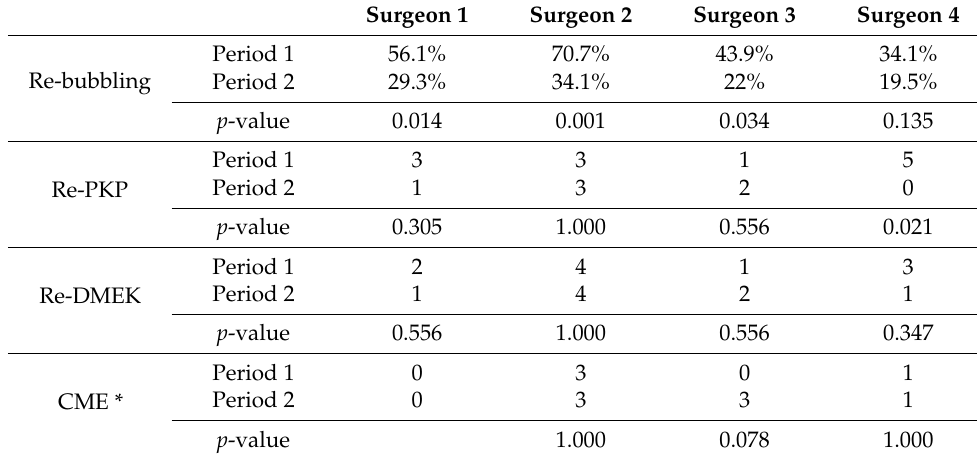
Table 5. Complications after DMEK for each